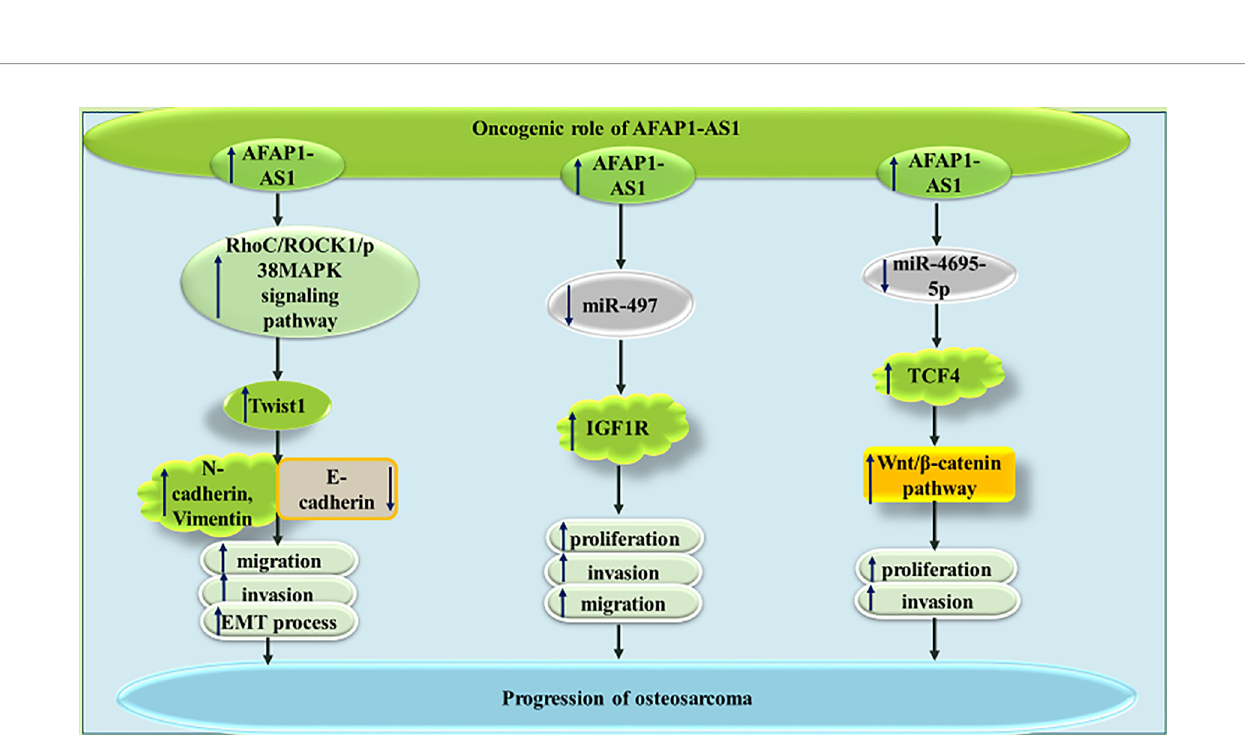
Frontiers in Oncology |